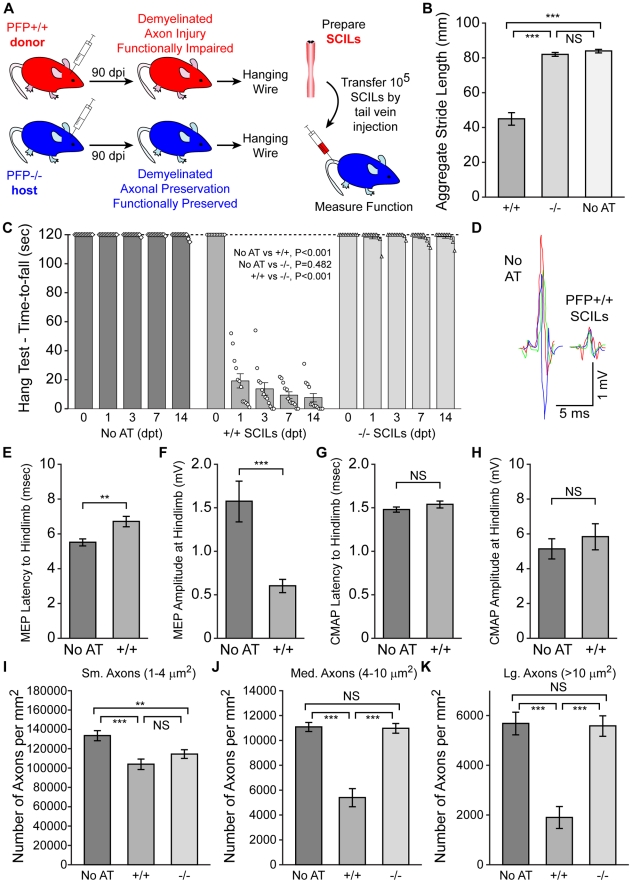
Function and axons are lost following adoptive transfer of perforin-competent cells.Adoptive transfer of perforin-competent spinal cord infiltrating leukocytes (SCILs) into demyelinated but functionally preserved perforin-deficient hosts induces rapid and permanent (>1 mo) loss of motor function and spinal axons. All data are presented as mean ±95% C.I. Statistical significance defined as *P<0.05, **P<0.01, ***P<0.001. Significance determined by one-way ANOVA with SNK pairwise posthoc analysis, except electrophysiology, which was analyzed by t-test, and the hanging wire test, which was analyzed by two-way ANOVA. All measurements made at 7 days post-transfer (dpt) unless otherwise indicated. No AT  =  no adoptive transfer controls; +/+  =  adoptive transfer of perforin-competent SCILs; −/−  =  adoptive transfer of perforin-deficient SCILs. (A) Schematic representation of the adoptive transfer paradigm. (B) Adoptive transfer of perforin-competent SCILs into perforin-deficient hosts at 90 dpi results in significant loss of function as assessed by footprint analysis. In contrast, adoptive transfer of perforin-deficient SCILs into perforin-deficient hosts causes no loss of function. (C) Longitudinal analysis of motor function by the hanging wire test shows that adoptive transfer of perforin-competent SCILs into 90 dpi perforin-deficient hosts results in a very rapid loss of function that does not recover over the analyzed time frame. Each symbol represents an individual animal. (D) Representative motor evoked potentials (MEP) in perforin-deficient 90 dpi hosts receiving either no adoptive transfer or perforin-competent SCILs adoptive transfer. (E-H) Central motor conduction latency (E) and amplitude (F) were significantly altered by adoptive transfer of perforin-competent SCILs as compared to perforin-deficient mice at 90 dpi that received no adoptive transfer. In contrast, peripheral compound motor action potential (CMAP) latency (G) and amplitude (H) were unaffected by adoptive transfer. (I-K) Adoptive transfer of perforin-competent SCILs into 90 dpi perforin-deficient hosts resulted in significant loss of small- (I), medium- (J), and large- (K) caliber spinal axons as compared to perforin-deficient 90 dpi hosts that received no adoptive transfer. Transfer of perforin-deficient SCILs into perforin-deficient hosts caused no loss of medium- (J) or large- (K) caliber axons, but did induce a signficant reduction in small- (I) caliber axons.